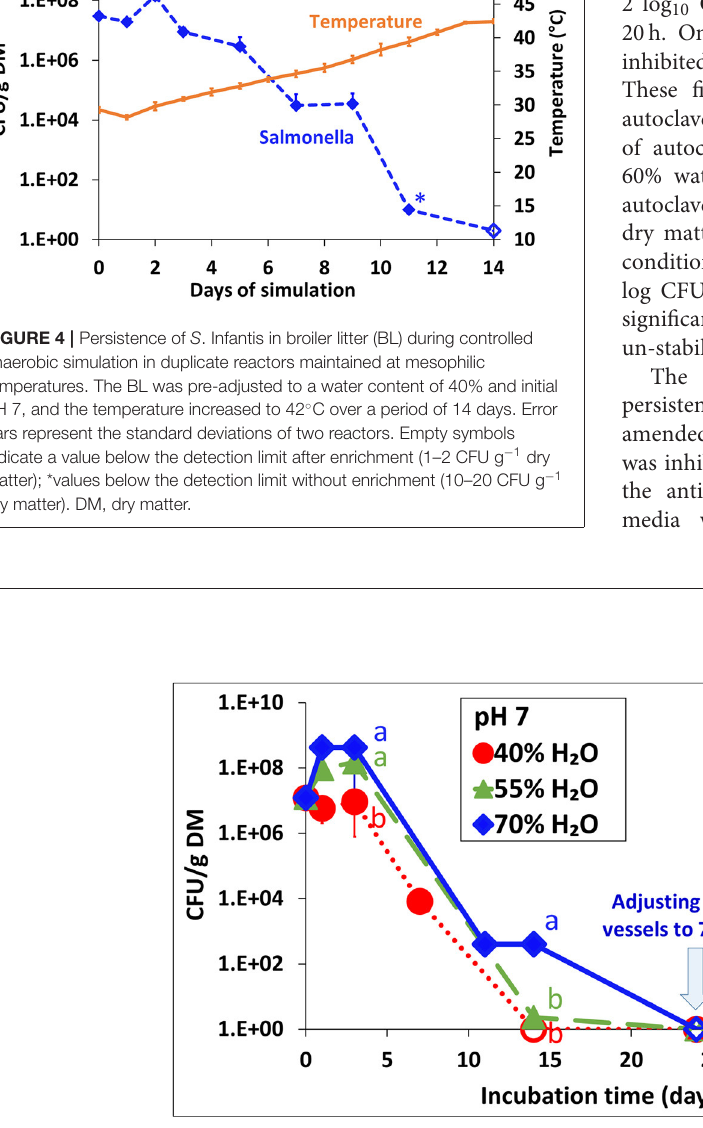
FIGURE 5 | Persistence of S. Infantis in broiler litter (BL) following re-wetting of samples which were incubated for 24 days at 30 ◦ C and various water contents (as shown in Figure 1 ). The vessels were incubated for additional 14 days following adjustment of water content to 70% in BL that was initially incubated at 40 and 55% water content (initial pH 7) and in the BL that was initially incubated at 40% water content also for initial pH of 6 and 8.5 (inset). Error bars represent the standard deviations of triplicate vessels. Letters denote significant differences between treatments at time intervals (log-transformed CFU values; Tukey-Kramer HSD; P ≤ 0.05). Empty symbols indicate values below the detection limit after enrichment (1–2 CFU g − 1 dry matter). DM, dry